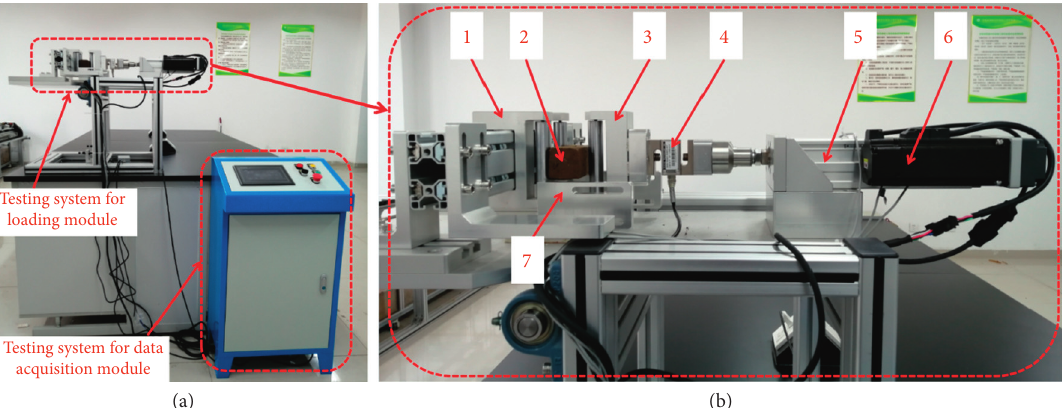
Figure 4: Experimental testing system of the TPB test on compacted clay. (a) The whole testing system; (b) mechanical properties test platform, in which label 1 is the adjustable support frame, label 2 is the CCB specimen, label 3 is the loading point, label 4 is a pressure transducer, label 5 is the electric cylinder, label 6 is the servomotor, and label 7 is the support plate.